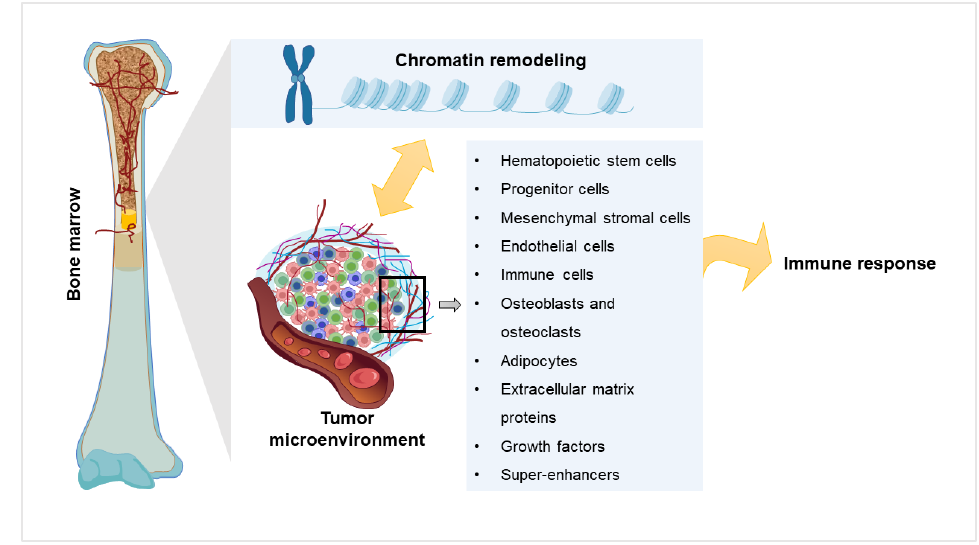
Figure 2. Crosstalk of the components of the tumor microenvironment with chromatin remodeling network.